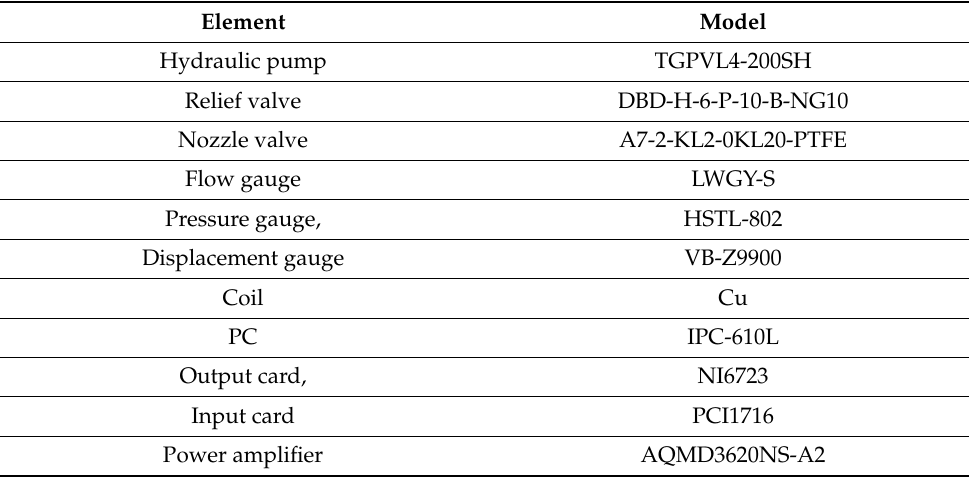
Table 3. Parameters of experimental